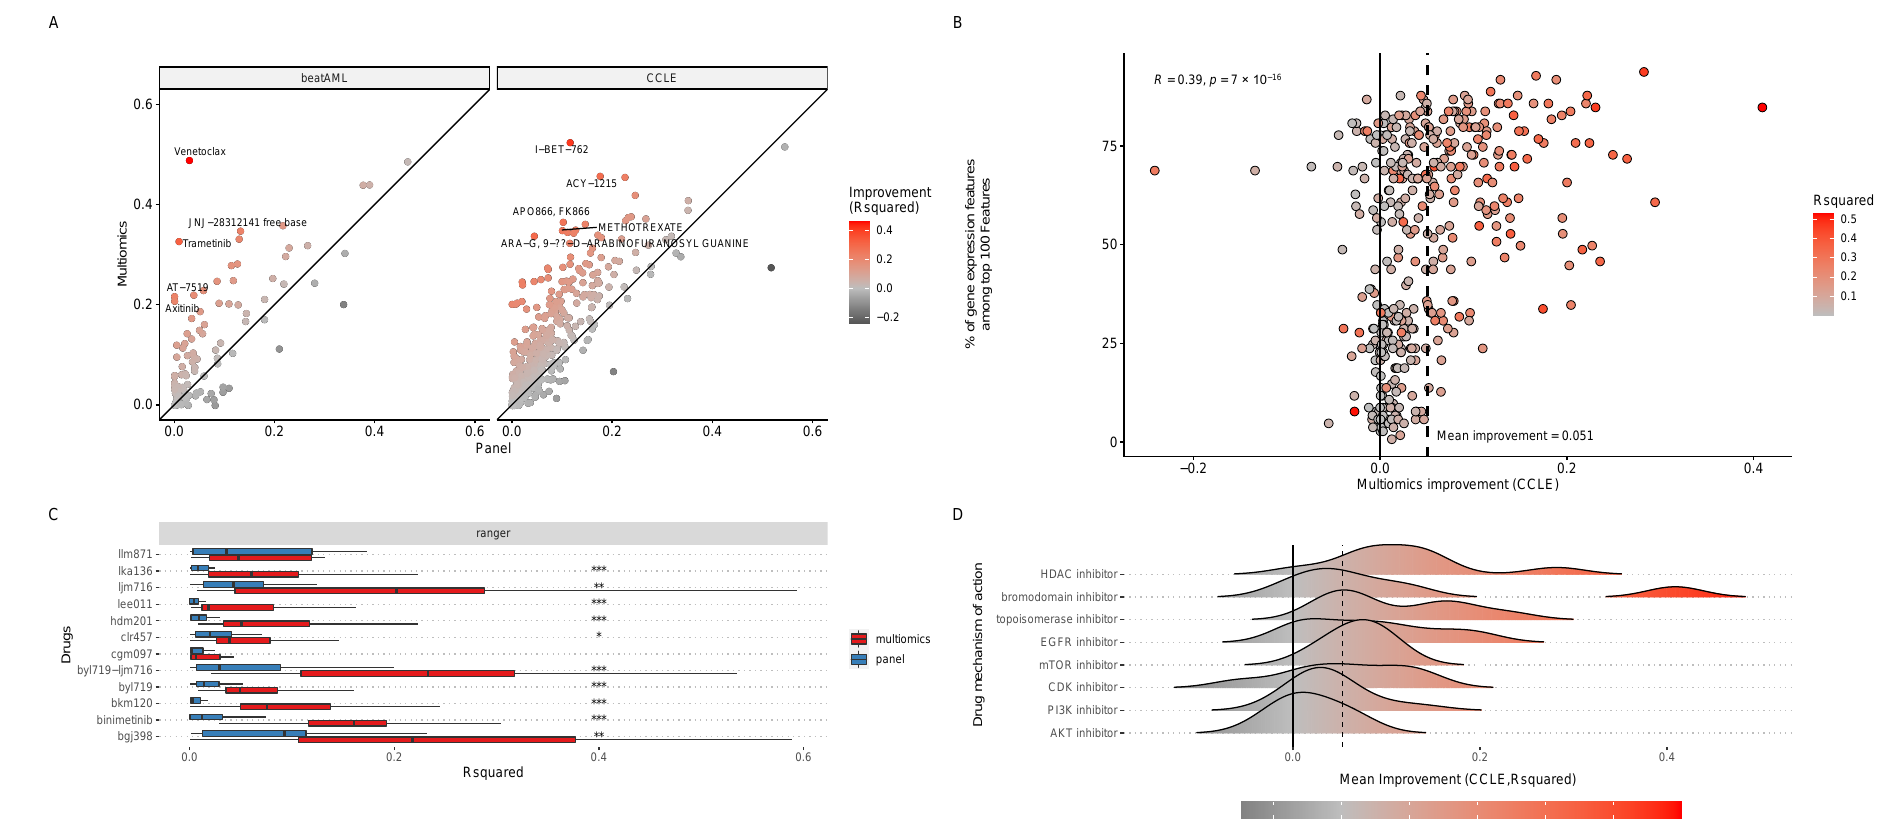
Figure 1. Evaluation of the performance of drug response prediction when using only panel-seq features (mutations and/or copy number variations) or using transcriptome features in combination with panel-seq features (multi-omics). ( A ) Improvement of multi-omics (as in R-square metric) in comparison to panel-seq features for the testing portion of BeatAML ( left panel) and CCLE ( right panel) datasets for 106 and 396 drugs, respectively. ( B ) Correlation of the prediction performance improvement (multi-omics vs. panel-seq) with respect to the proportion of transcriptome features among the top 100 most important predictors of drug response for CCLE datasets. ( C ) Improvement of multi-omics (in red) (as in R-square metric) in comparison to panel-seq features (in blue) for the testing portion of the PDX dataset for 12 drugs. Stars above the boxplots represent significance levels: *** for p < 0.001, ** for p < 0.01, * for p < 0.05. ( D ) Drug classes with loose pathway specificity show higher average improvement in MO over PS. Drug classes ( y -axis) are ordered by average improvement in MO and filtered to keep only those that have a minimum of five drugs in a class. The dashed line corresponds to the global average improvement in MO (0.051) as reported in figure panel ( C